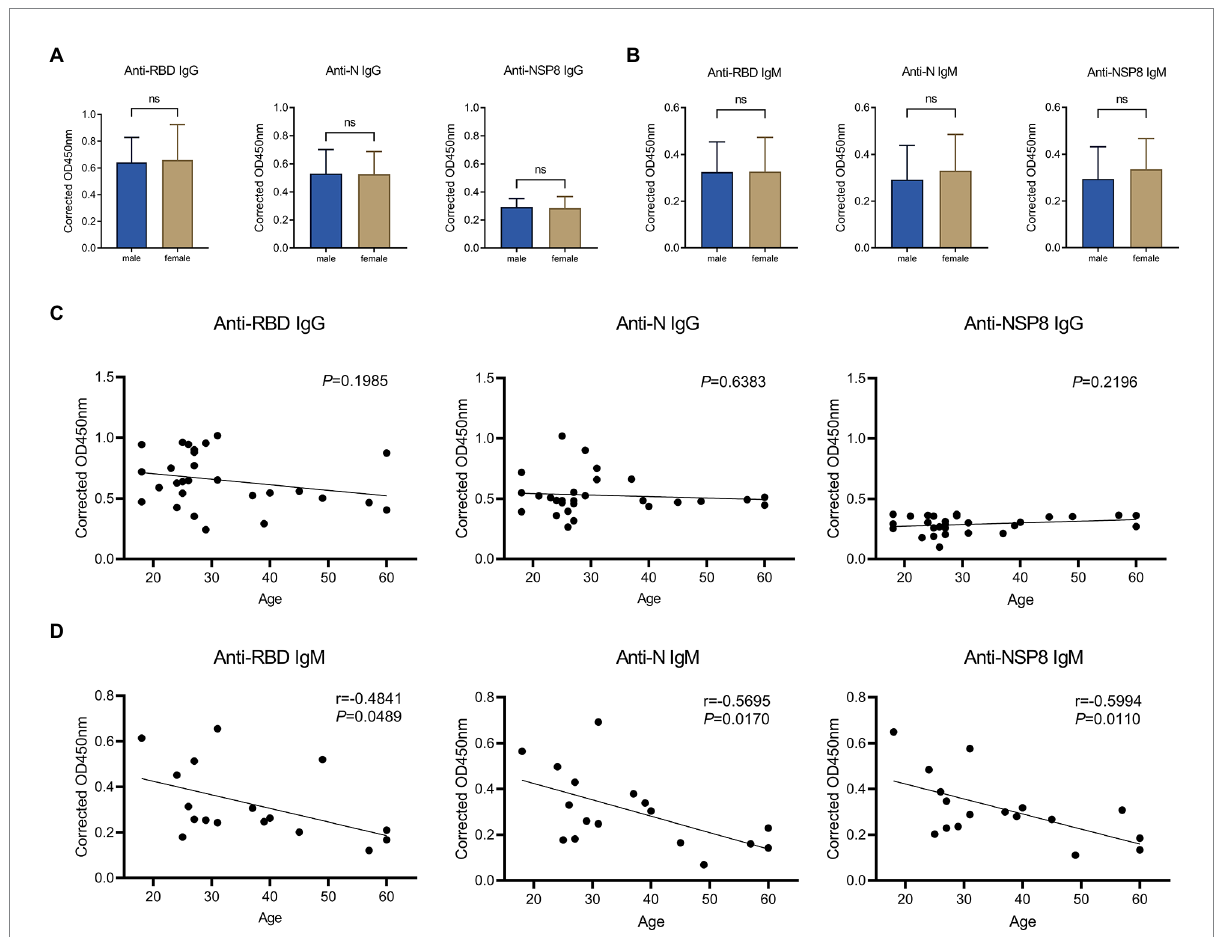
FIGURE 5 Correlation of SARS-CoV-2 specific antibody responses to gender or age. (A) SARS-CoV-2 specific IgG response of male vs. female to the RBD, N, and NSP8. Serums were collected from the 10–30 days after the 2 nd dose vaccination group ( n = 28). (B) IgM responses of male vs. female to the RBD, N protein, and NSP8. Serums were collected from the 10–30 days after the 2 nd dose vaccination group ( n = 28). The p - value was calculated by the Student’s t -test or Mann–Whitney test. (C) Correlation of RBD-, N-, and NSP8-specific IgG responses to age. Serums were collected from the 10–30 days after the 2 nd dose vaccination group ( n = 28). (D) Correlation of RBD-, N-, and NSP8-specific IgM responses to age. Serums were collected from the 10–30 days after the 2 nd dose vaccination group ( n = 28). A correlation test was conducted using Pearson